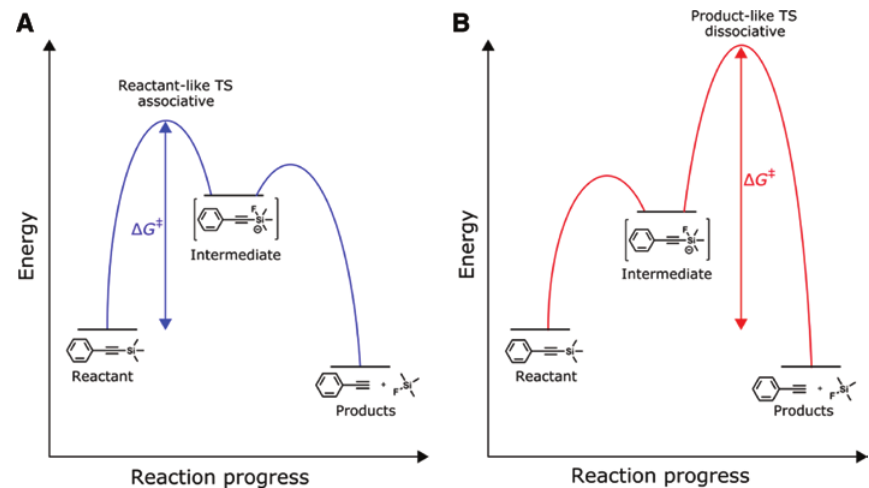
Figure 4: Vibrational strong coupling modifies the reactive landscape to a dissociative path. Schematic illustration of possible transition states under (A) noncavity and (B)